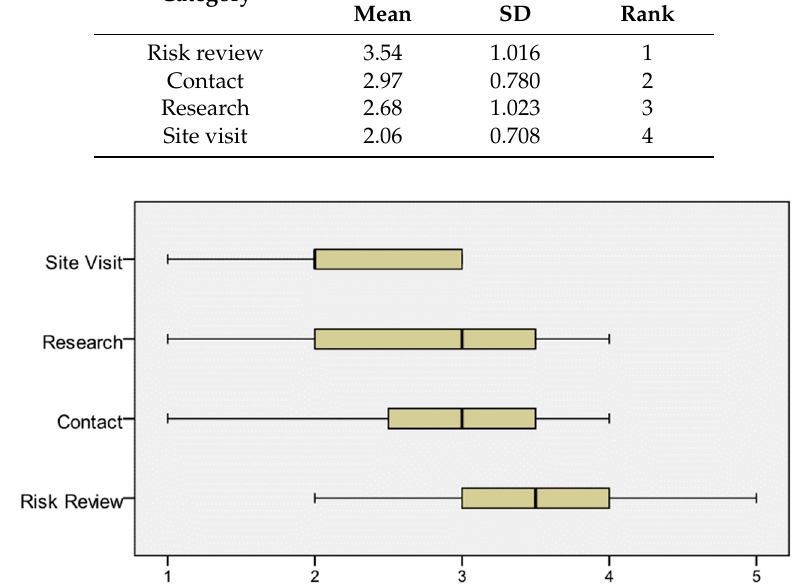
Figure 4. How risks are identified by the companies.